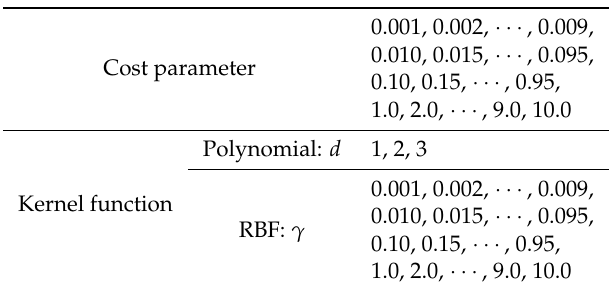
Table 3. Parameter ranges in grid searching.